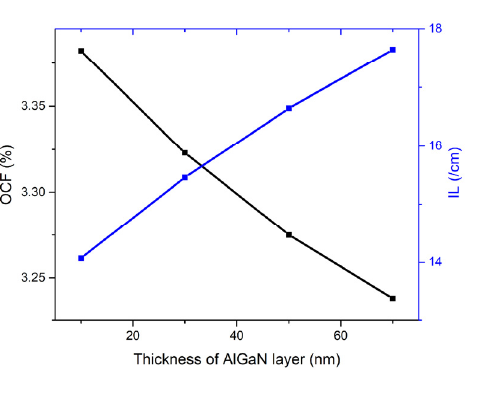
Figure 4. Simulation results for LDs with different thicknesses of the AlGaN layer in CLQB. The threshold current (black) and SE (blue) values are extracted from P–I curves (not shown here). For convenience, the threshold current value is taken when the optical output power reaches 1 mW.